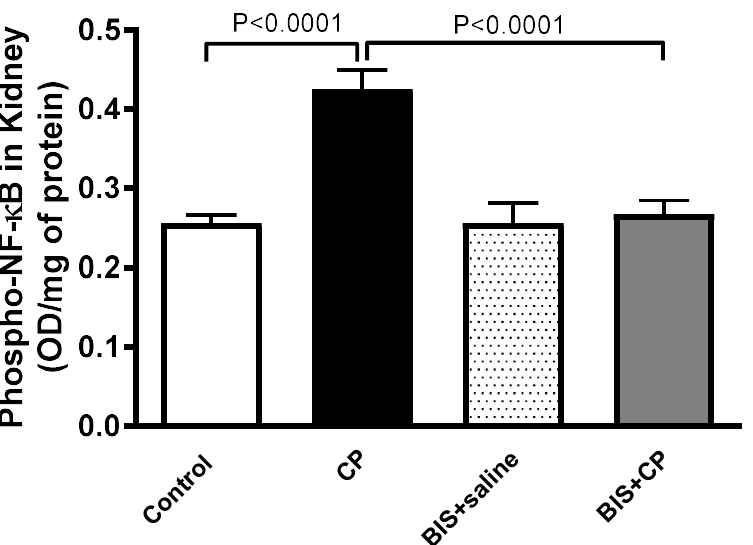
Figure 9. Phosphorylated nuclear factor-κB (phospho-NF-κB) expression in the kidney of mice treated orally with either sunflower oil (control) or bisabolol (BIS, 25 mg/kg) with or without cisplatin (CP, 20 mg/kg) given intraperitoneally (n = 8). Mean ± SEM. Statistical analysis by ANOVA 1 followed by Holm Sidak’s test.